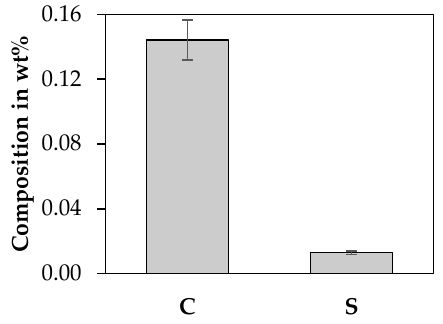
Figure 2. Carbon and sulfur content of chromite concentrate.